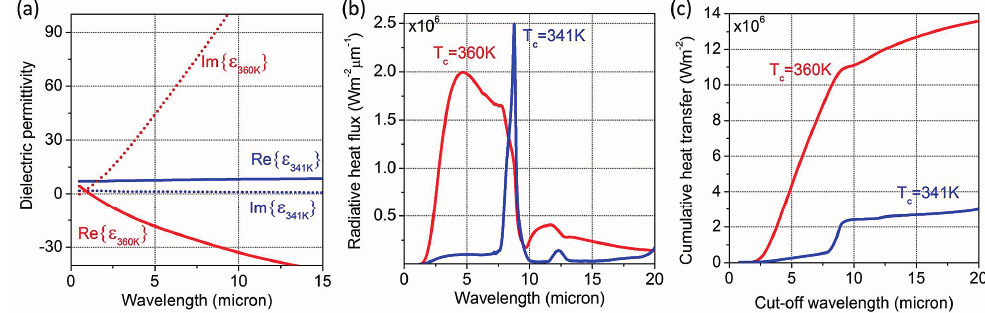
Figure 8. ( a ) Complex dielectric permittivities of VO 2 in the metal phase (red lines) and insulator phase (blue lines). The real part of permittivity is plotted as solid lines and the imaginary parts as dotted lines. ( b ) The heat flux spectra as a function of wavelength between 2 nm-thin VO 2 films on SiO 2 substrates at an emitter temperature of 1000 K and an absorber temperature either at 360 K (red dotted line) or 341 K (solid blue line). The emitter and absorber are separated by a 20 nm vacuum